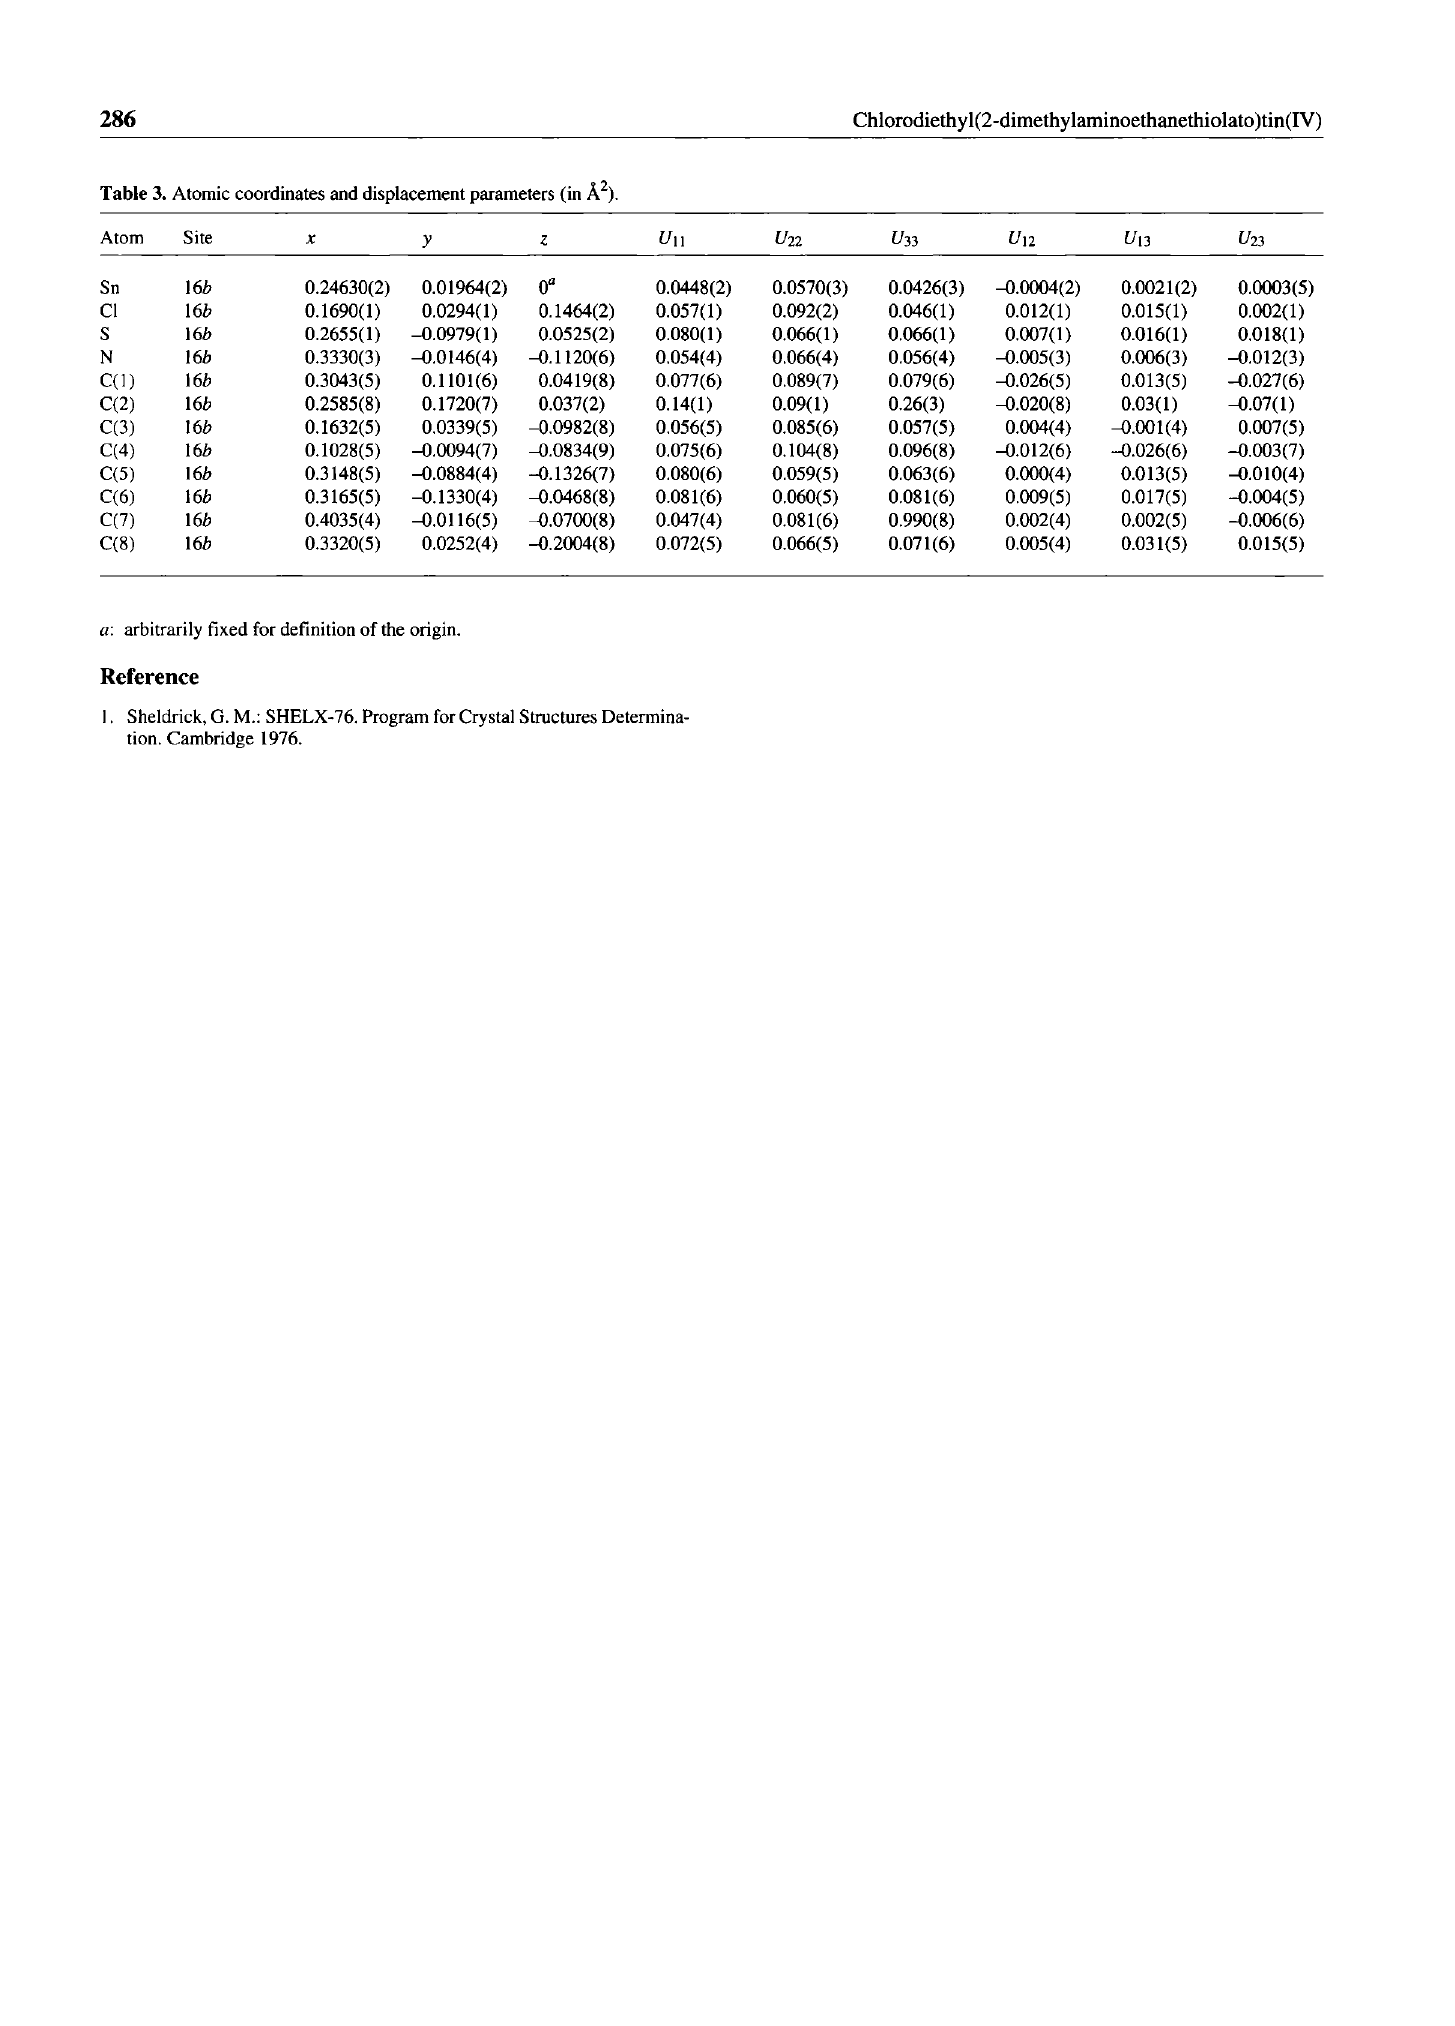
Table 3. Atomic coordinates and displacement parameters (in A 2